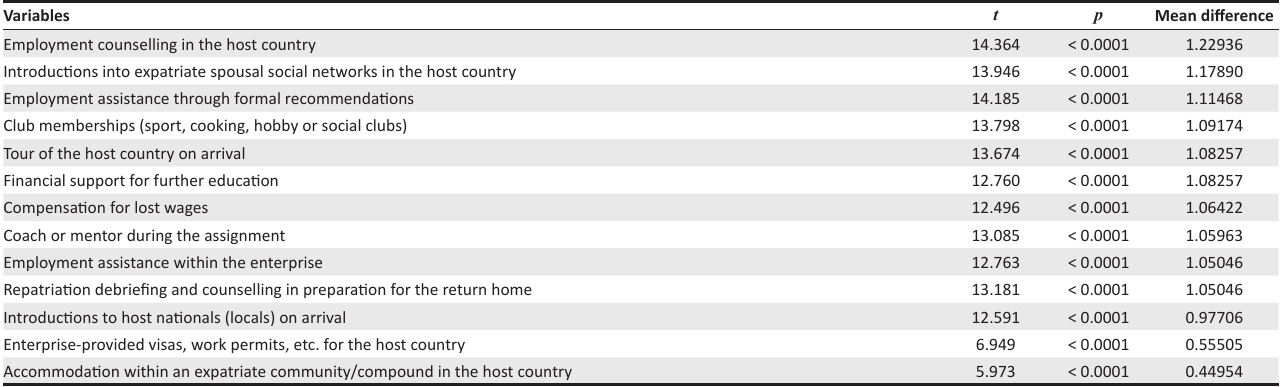
TABLE 6: Individual t -test results for support required versus support provided. Variables